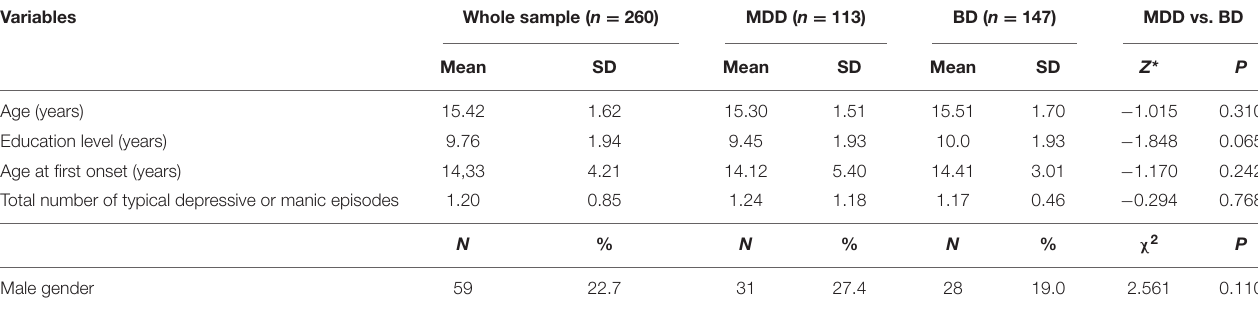
TABLE 1 | Basic demographic and clinical characteristics of adolescents diagnosed with MDD or BD.